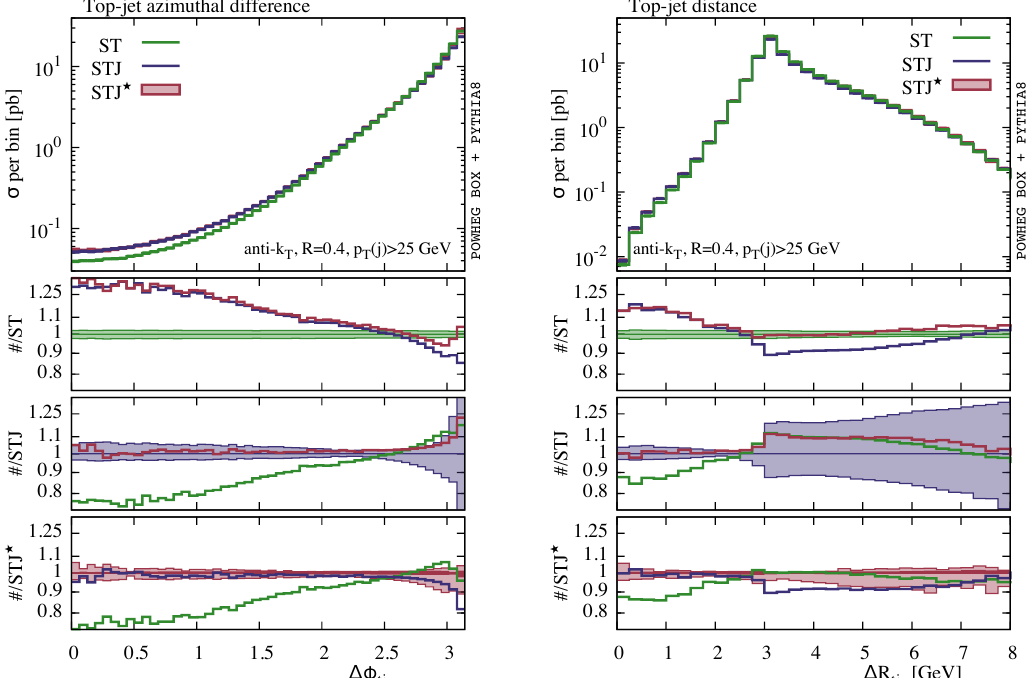
Figure 5 . The azimuthal separation of the top quark and the leading jet (left), and the (cid:17) (cid:0) (cid:30) plane distance, (cid:1) R tj = ((cid:1) (cid:30) 2 + (cid:1) (cid:17) 2 ) 1 2 , between the same two objects (right). Predictions from tj tj 1 the Powheg ST program [52] are shown in green. Results from the new Minlo STJ simulation are displayed in blue, while those of its improved counterpart, STJ ? , appear in red. All predictions include parton shower e(cid:11)ects simulated by Pythia8